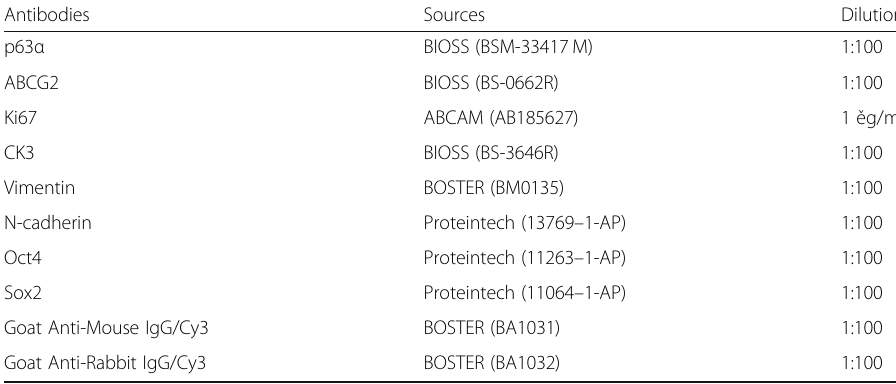
Table 1 Antibodies used for immunofluorescent staining Antibodies Sources Dilution p63 α